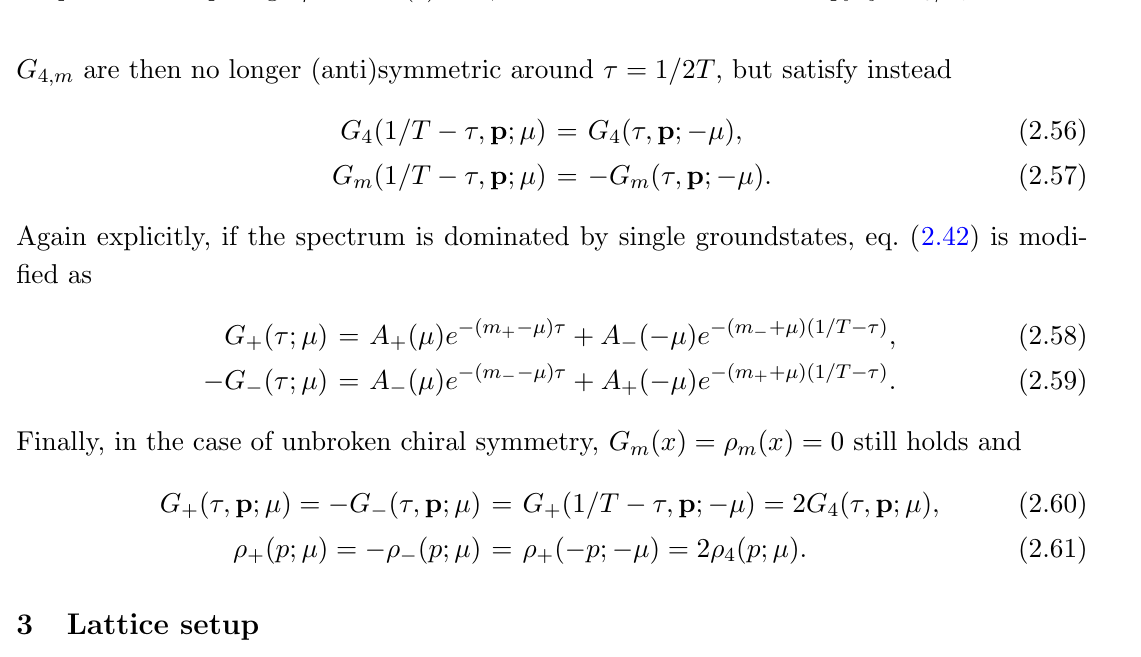
Table 1 . Ensembles used in this work. The lattice size is N 3 N (cid:28) , with the temperature s (cid:2) T = 1 = ( a (cid:28) N (cid:28) ). The available statistics for each ensemble is N cfg N src . The sources were chosen (cid:2) randomly in the four-dimensional lattice. The spatial lattice spacing a s = 0 : 1227(8) fm, the inverse temporal lattice spacing a (cid:0) 1 = 5 : 63(4) GeV, and the renormalised anisotropy (cid:24) = a s =a (cid:28) = 3 : (cid:28)